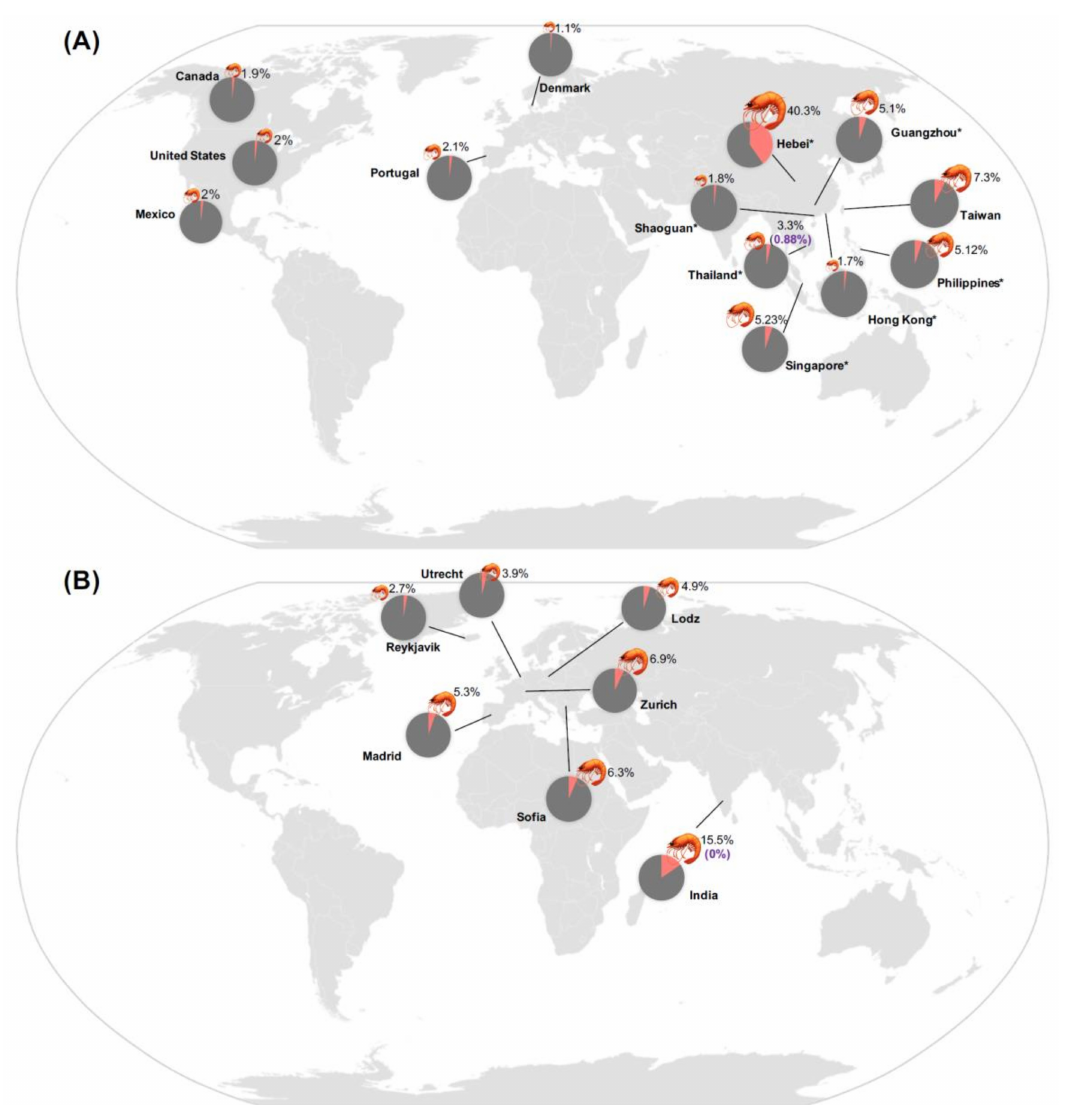
Figure 1. Prevalence of shellfish allergy. The estimated rate of shellfish allergy (pink) in populations at di ff erent geographical areas based on ( A ) self-reports and ( B ) IgE sensitization. Percentage in purple indicates the prevalence of shellfish allergy based on oral food challenge results. Asterisk (*) indicates that only children and / or adolescent populations aged 18 years or below were included in the estimation of shellfish allergy